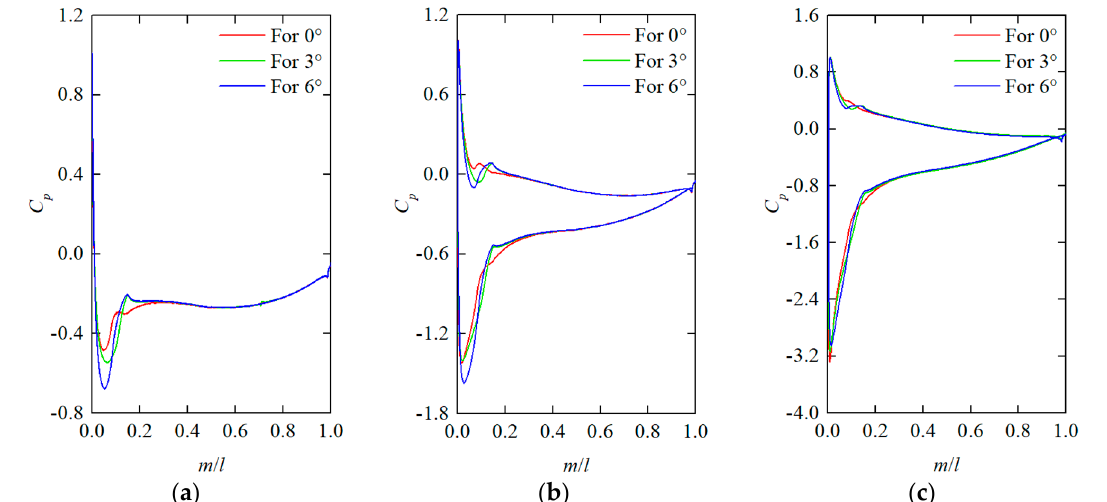
Figure 8. Surface pressure distribution curves of the three optimal foils under different incidence angles: ( a ) α = 0°; ( b ) α = 3°; ( c ) α = 6°.